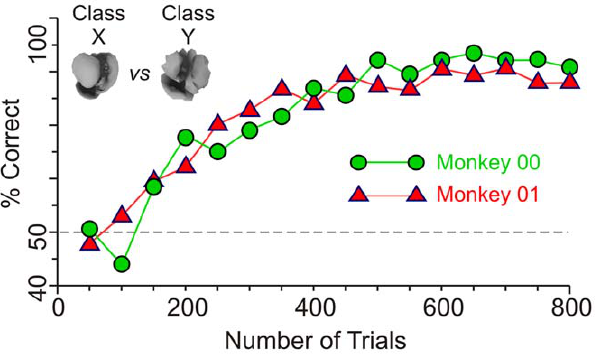
Figure 3. Changes in categorization performance as a function of training. Two animals fully trained in the categorization task learned two hitherto unknown categories ( icons at top left ). The percentages of correct trials during successive blocks of 50 trials each are shown for each animal. The dashed line represents chance level performance (50% correct). The training shown took 38 and 42 min from beginning to end, for Monkey 00 and Monkey 01, respectively. These learning durations mean that one can, in principle, carry out simultaneous microelectrode recordings of neuronal activity. See text for